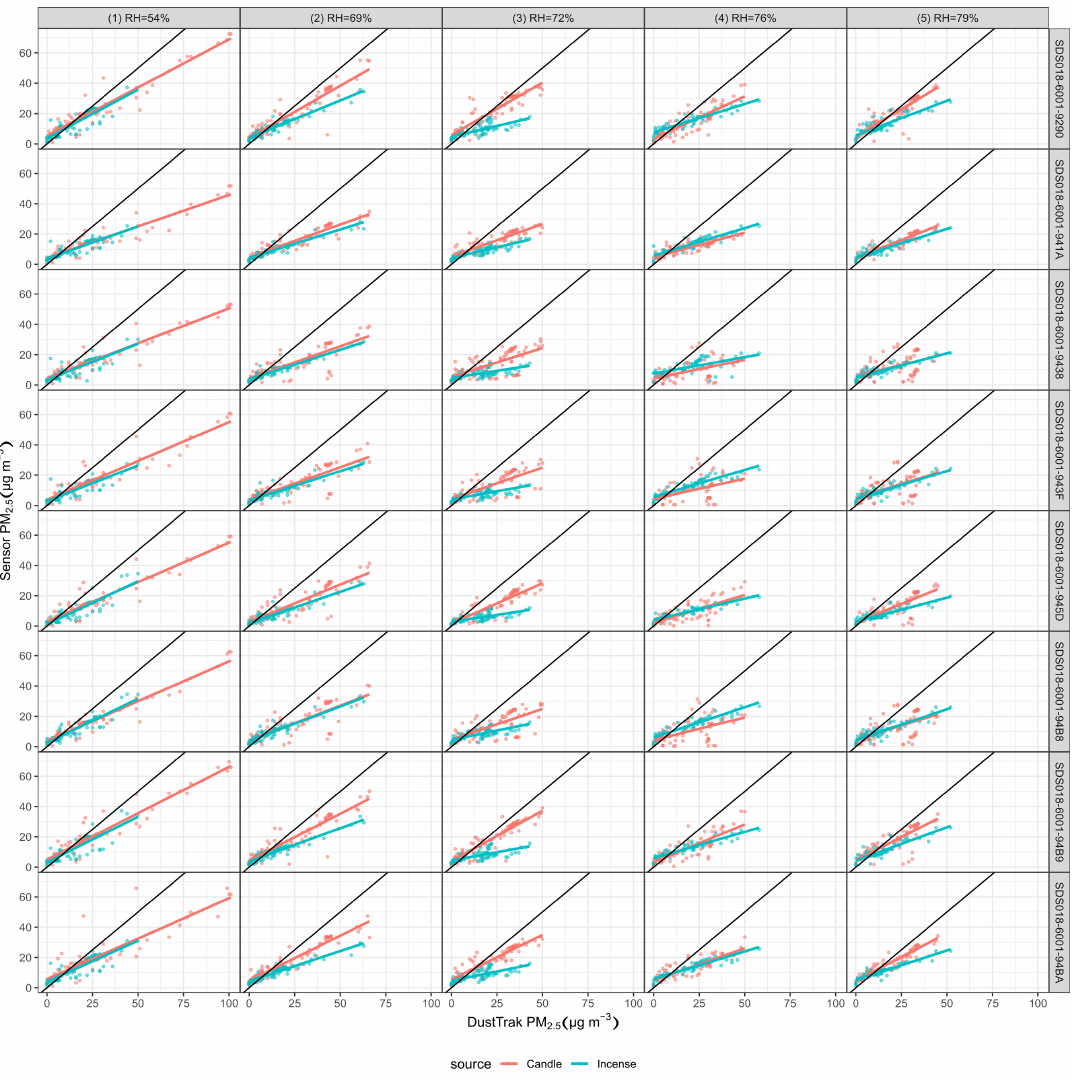
Figure A7. Comparison and linear regression of the Novafitness SDS018 with the DustTrak (x = DustTrak, y = sensors) during the five experiments for peaks and stable concentrations of PM generated using incense and candle. The black line is x =